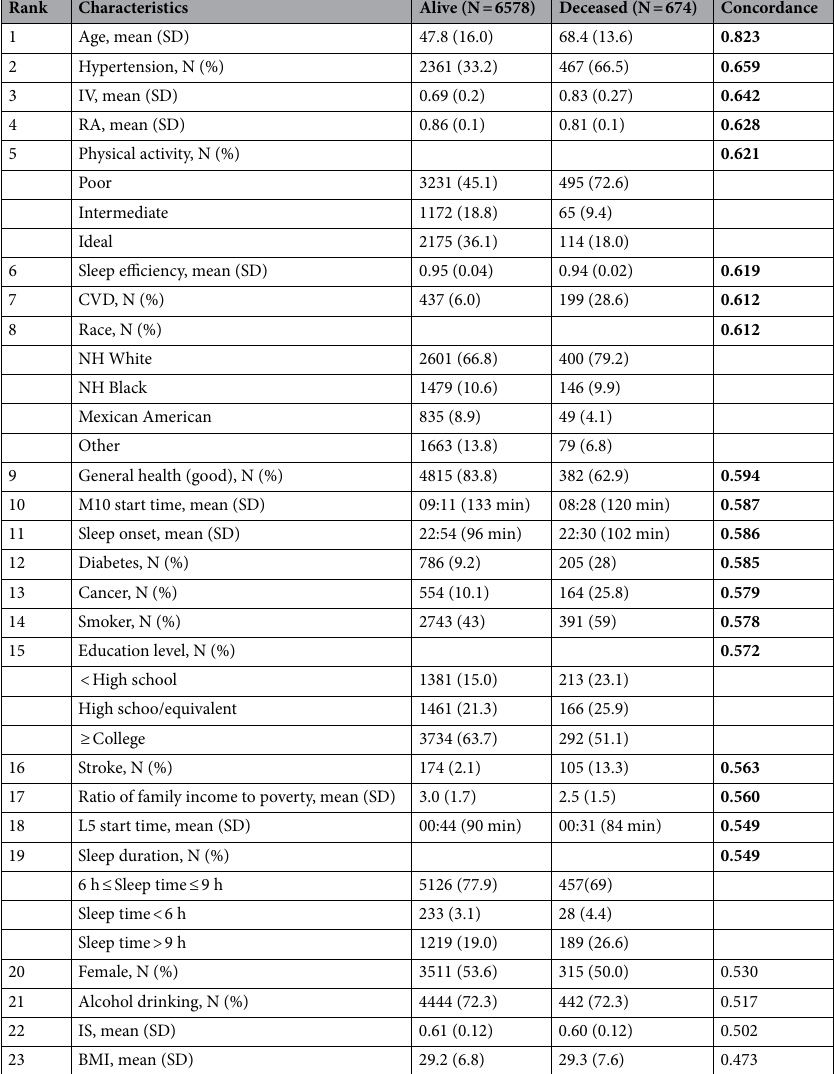
Table 1. Population characteristics stratified by mortality status at follow-up ordered by estimated concordance from univariate cox regressions (n = 7252). IQR Interquartile range; NH Non-Hispanic; BMI Body mass index; RA Relative amplitude; IS Interdaily stability; IV Intradaily variability; M10 The most active continuous 10-h period; L5 The least active continuous 5-h period. % and means (SD)/medians (IQR) were weight adjusted. Bold denoted a statistical significance in the univariate cox